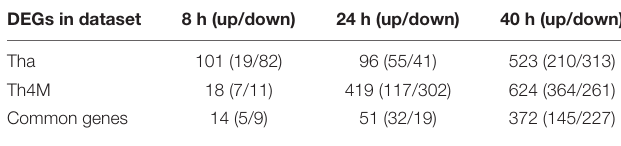
TABLE 1 | DEG regulation in Tha and Th4M datasets. Number of up- and down-regulated genes are marked in parentheses. DEGs in